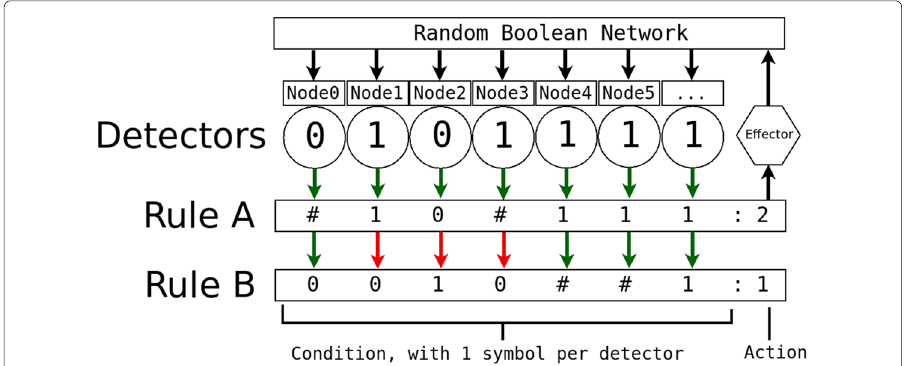
Fig. 1 A simple example of rule matching with two rules with ternary (three state) condition components and one binary environmental state. Adapted from (Matthew R Karlsen and Sotiris Moschoyiannis: